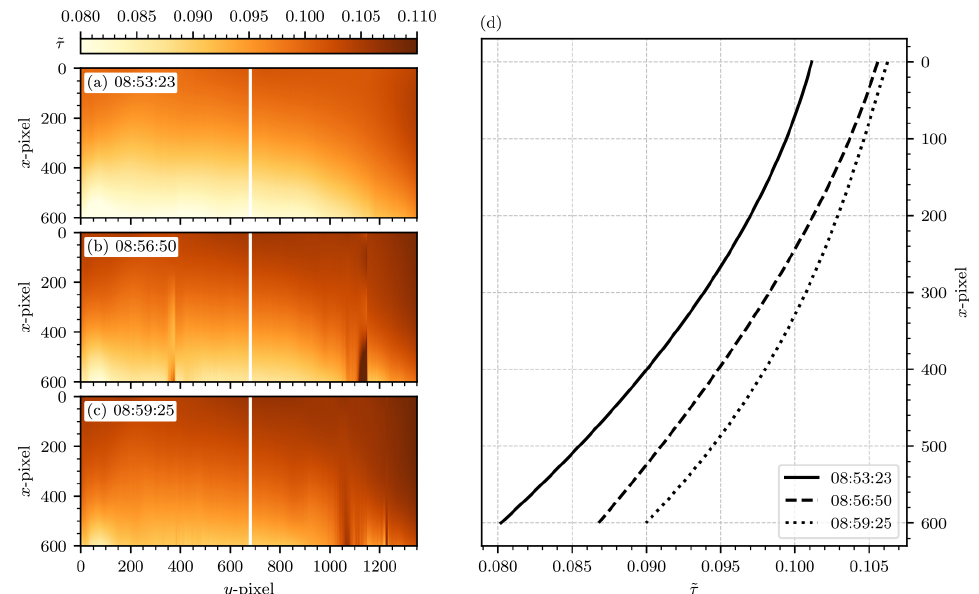
Figure 13. Temporal variance of the background images obtained from the background fit routine described in Sect. 4.2.1. Panels (a) – (c) show the background fit to three images acquired at 08:53:23UTC+2, 08:56:50UTC+2, and 08:59:25UTC+2, respectively. (d) Plots of the background signal along the white vertical lines at y = 660 in (a) – (c) . Altogether, the figure demonstrates the temporal variability in both magnitude and shape of the background